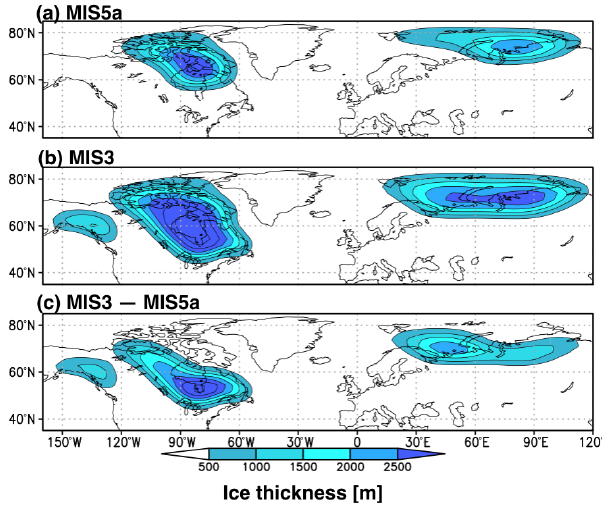
Figure 2. Ice sheet thickness of (a) MIS5a (80ka), (b) MIS3 (36ka) and (c) MIS3 minus MIS5a. Results from an ice sheet model are presented (Abe-Ouchi et al., 2013). These ice sheet configurations were used for climate model simulations.